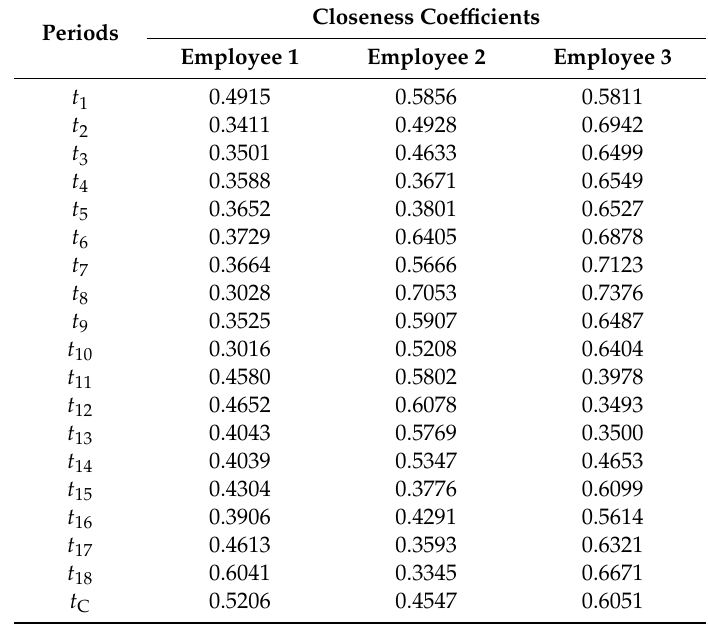
Table 13. Closeness coe ffi cients of employees.